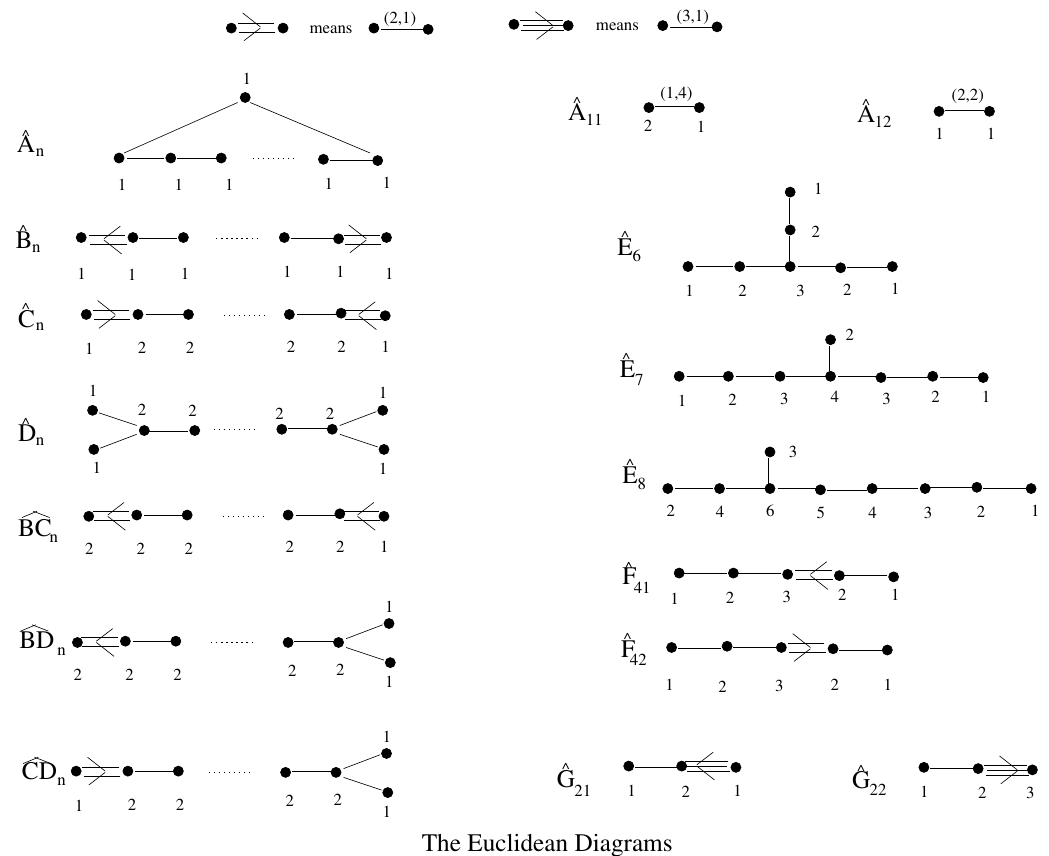
Figure 3. The Euclidean Diagrams as labeled quivers; we recognise that this list contains the so-called Affine Dynkin Diagrams (from Chapter 4 of